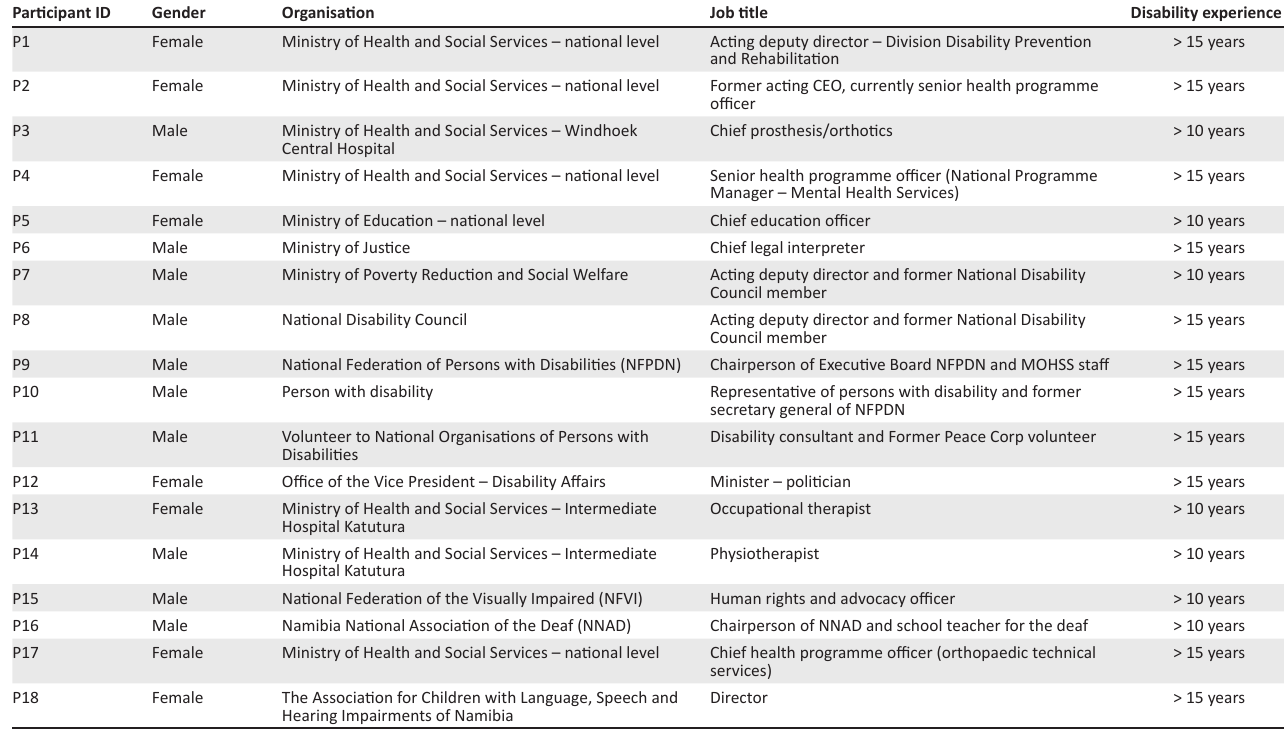
TABLE 1: Participants’